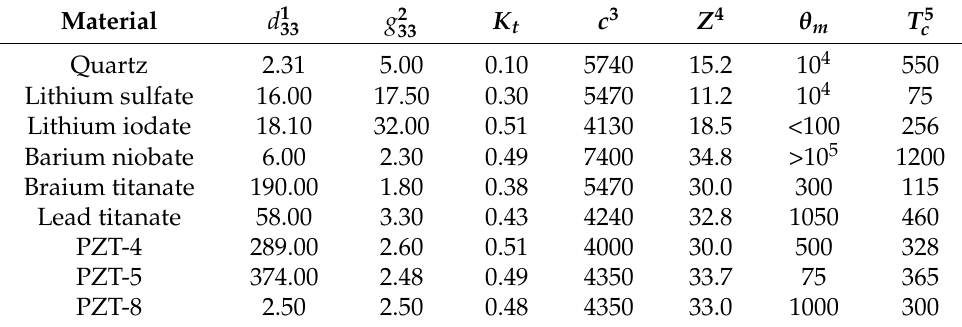
Table 3. Key parameters of piezoelectric